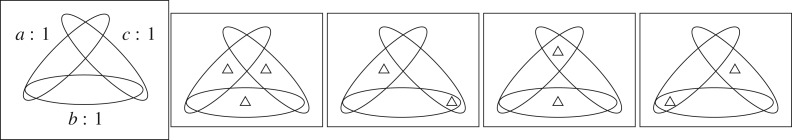
Example topology with three sensors a, b and c and four feasible target distributions.